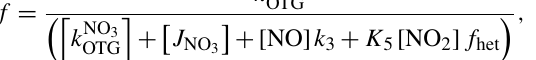
Figure 9. The fraction, f , of the total NO 3 loss with organic trace gases as a campaign mean diel cycle where f = k NO 3 +[ NO ] k + K [ NO ] f J NO 3 5 2 het ) . The error bars reflect variability 3 only and do not consider systematic